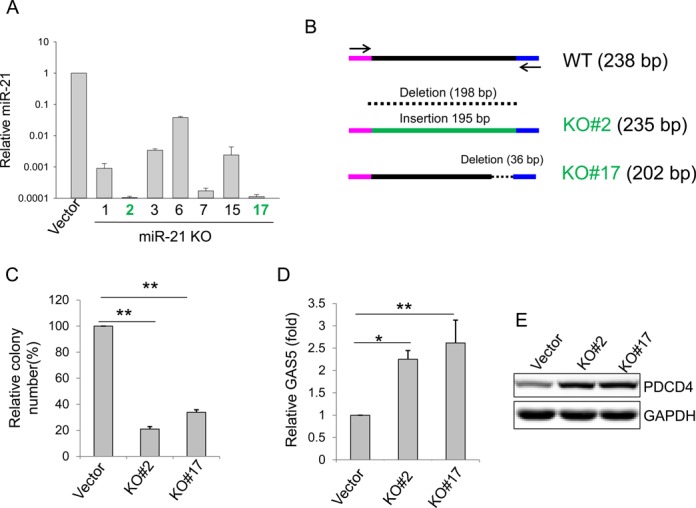
Characterization of miR-21 KO clones in HCT-116. (A) Detection of miR-21 in miR-21 KO clones by qRT-PCR; P value <0.01 for all seven clones compared to vector control. miR-21 KO #2 and #17 (in green) were selected for further analysis. (B) Detection of alterations at the target region of miR-21 KO #2 and #17 by DNA sequencing. (C) miR-21 knockout suppresses cell growth, as determined by colony formation assays. (D) miR-21 knockout increases the miR-21 target GAS5, as detected by qRT-PCR. (E) miR-21 knockout increases the miR-21 target PDCD4, as detected by western blot. Values in (C) and (D) are means of ± SE (n = 3). *P < 0.05 and **P < 0.01.